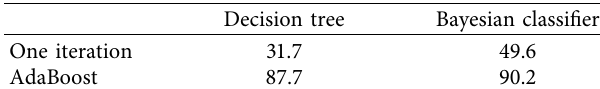
Table 6: Accuracy of 3D model classification under different